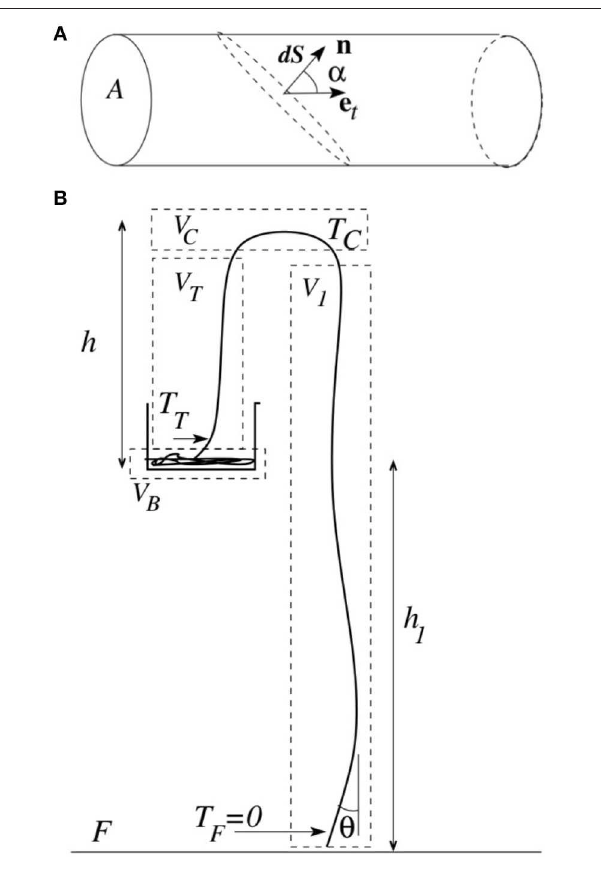
FIGURE 2 | (A) The cross-section of a homogeneous chain. (B) The lengths defining the average chain configuration as well as the integration volumes and local tensions. The tensions are measured where the chain intersects the integration volumes. The floor at z = 0 is indicated by the horizontal line in the bottom of the